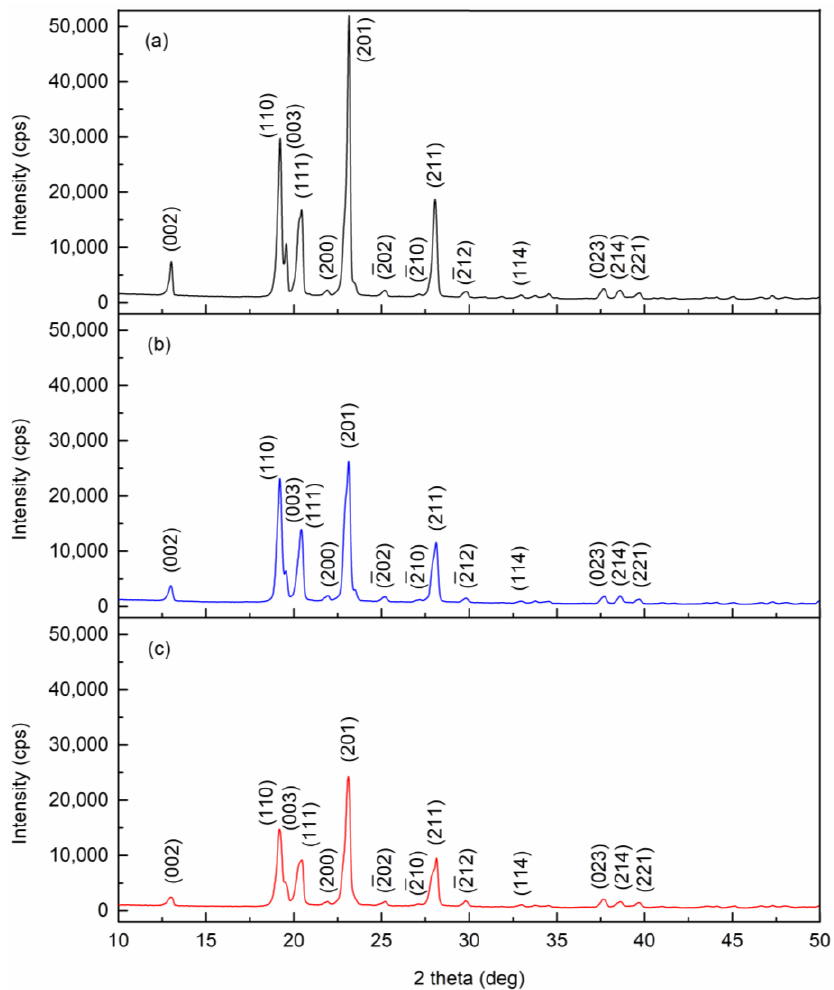
Figure 3. Powder X-ray diffraction patterns of ( a ) pure, ( b ) 0.01 wt.%, and ( c ) 0.1 wt.% pentacene- doped p-terphenyl crystals. Table 1. Lattice parameters of pure and pentacene-doped p-terphenyl crystals.